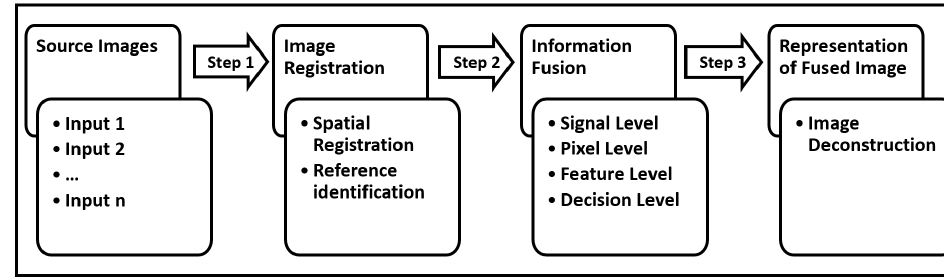
Figure 2. The main steps of a generic fusion